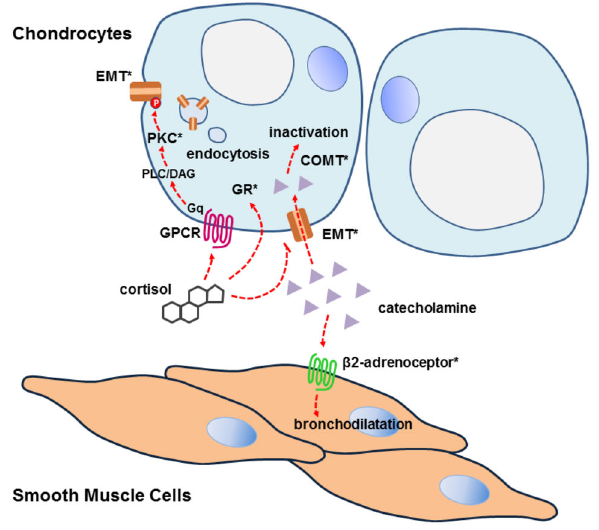
Figure 5. A putative EMT-centered model explains the permissive action of cortisol in trachea. EMT as the direct target is inhibited by cortisol, and this action slows down the reuptake process of catecholamines by chondrocytes, leading to extracellular catecholamines accumulation and more considerable adrenergic signaling activation in smooth muscle cells. Moreover, cortisol-initiated membrane signaling triggers PKC activation, which phosphorylates EMT and results in EMT internalization. Signaling components associated with airway disorders in genetic studies are labeled with asterisks